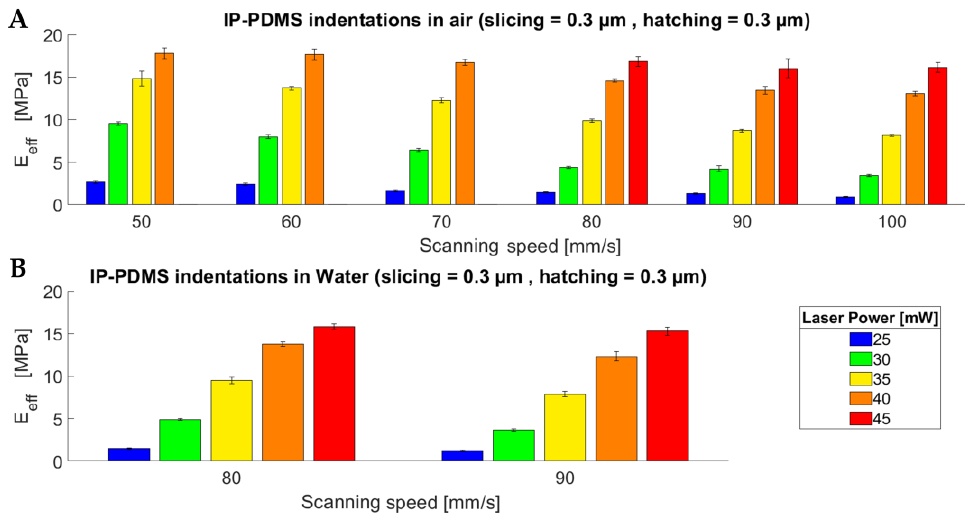
Figure 2. Indentation results showing the influence of the scanning speed on the effective Young’s modulus of IP-PDMS. ( A ) Indentations in air. ( B ) Indentations in water (room temperature).